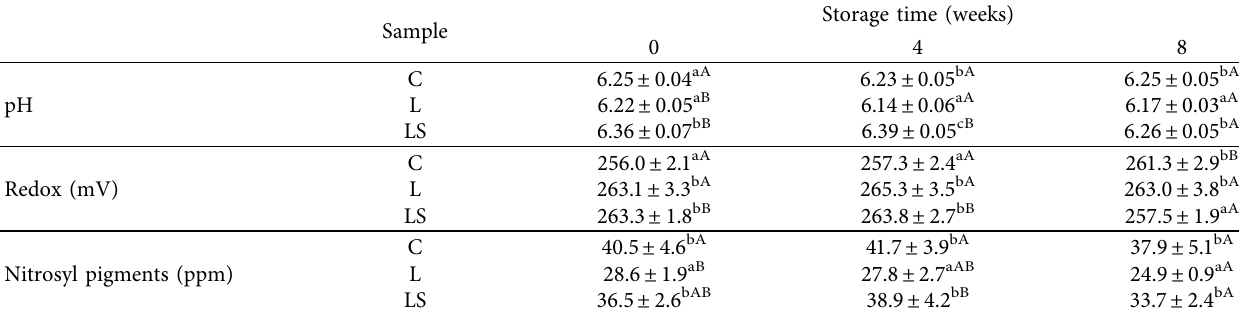
a–c Meansinthesamecolumns withdifferent superscriptsmalllettersdiffersignificantly( P ≤ 0 . 05). A,B Means inthesamerowwith differentsuperscript capital letters differ significantly ( P ≤ 0 . 05). C: control treatment, quantity added NaNO 2 100mg/kg; L: quantity added NaNO 2 —15mg/kg; LS: quantity